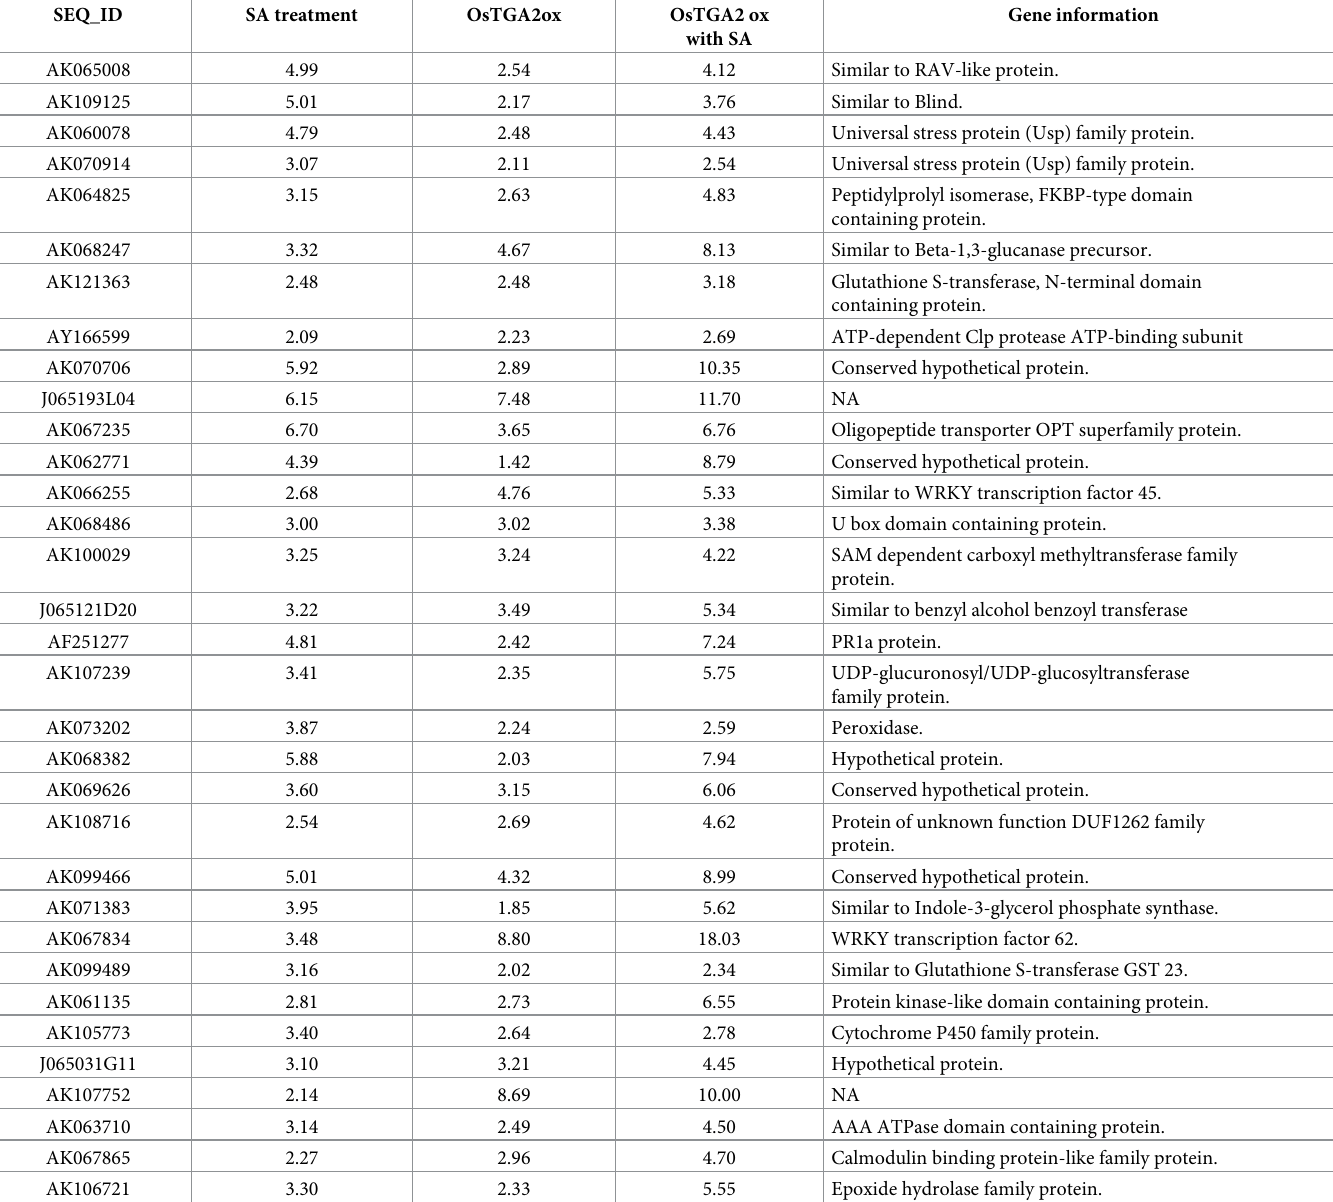
(Figs 6I and 6J) and UDP-glucuronosyl/UDP-glucosyltransferase family protein (Os07g0241500 / LOC_Os07g13770) (Fig 6K) exhibited similar patterns: their gene expressions were increased upon SA in wild-type while SA–induced gene expressions were more higher in OsTGA2 overexpression transgenic plants. In addition, the expression of Hsp70-Hsp90 organizing protein 1 (Os06g0159600 / LOC_Os06g06470) is increased in OsTGA2 overexpressor (Fig 6D). However, the expression of a Table 1. List of up-regulated and defense-related genes in OsTGA2 over-expression transgenic rice based on microarray analysis. SEQ_ID SA treatment OsTGA2ox OsTGA2 ox with SA